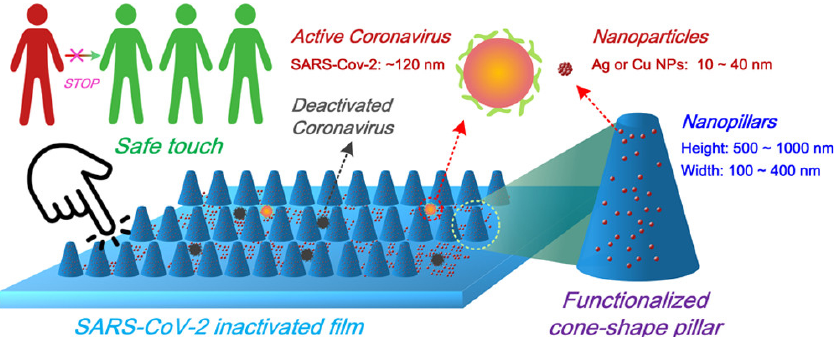
Figure 9. Simplified scheme about the design of functionalized nanoscale conical pillars with antiviral properties. Figure reused from Ref. [134] under the terms of CC BY 4.0